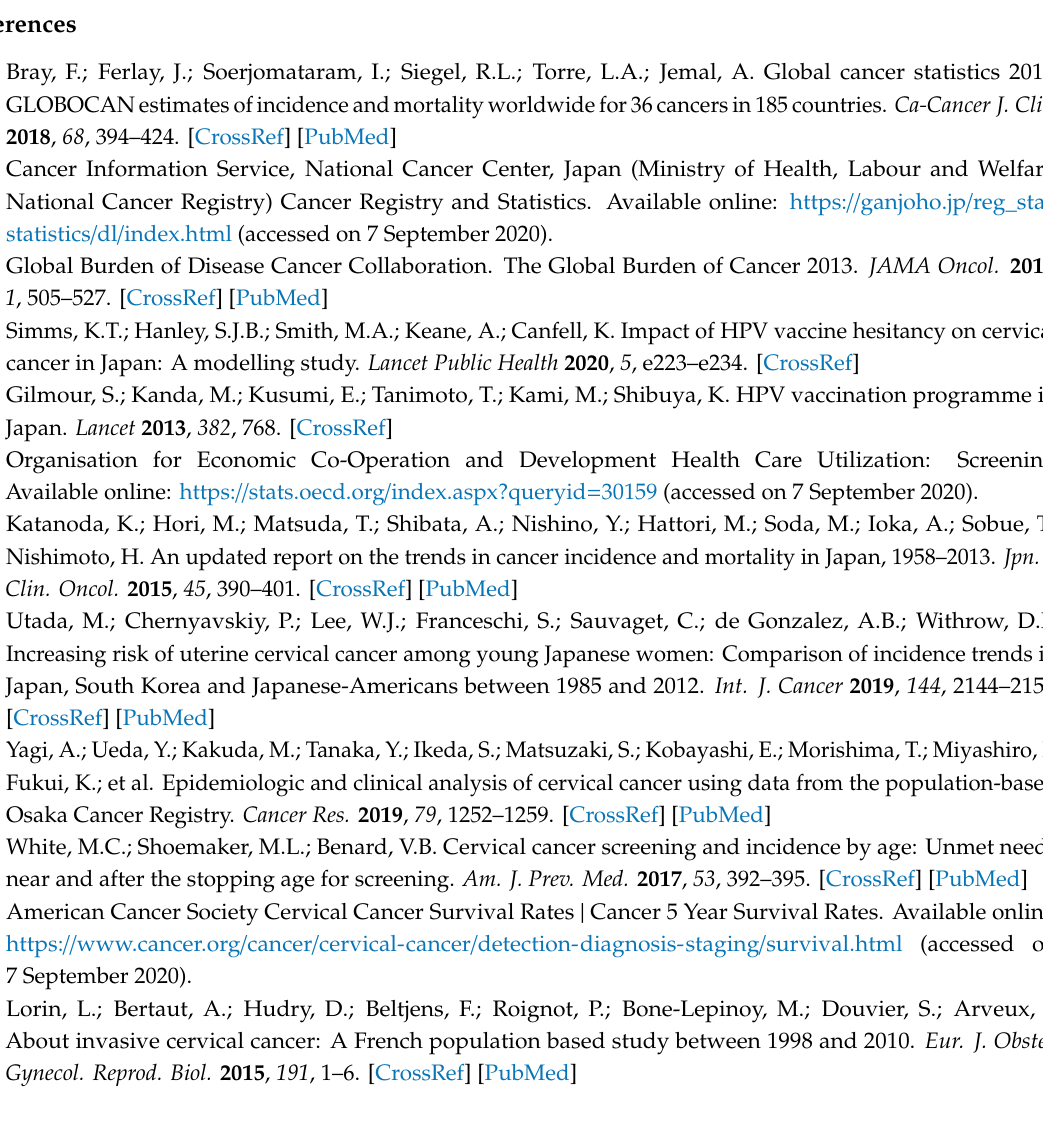
Figure S1: Age-specific average annual percent change for cervical cancer incidence in Tochigi prefecture